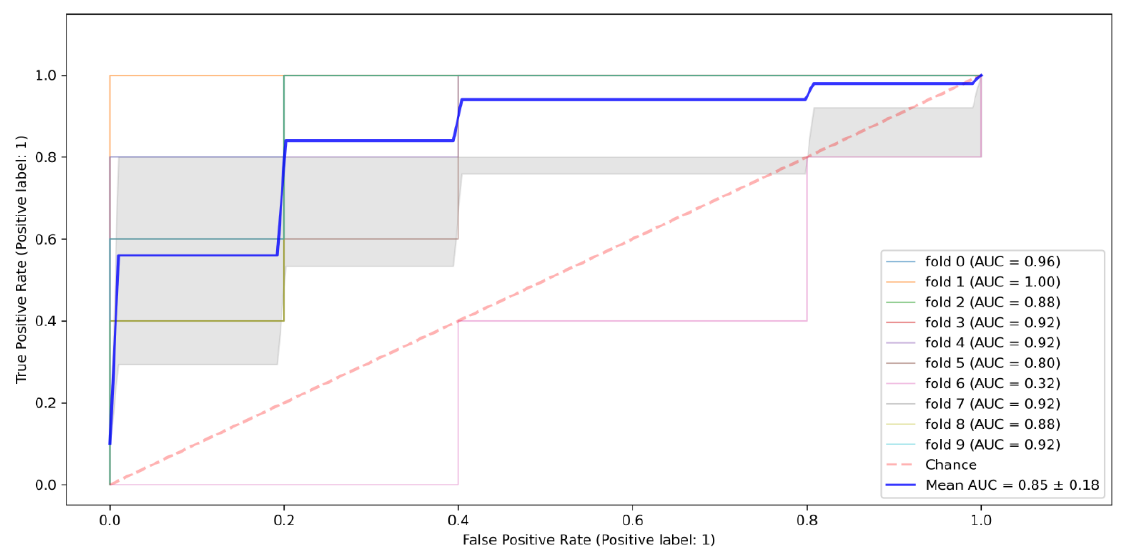
Figure 6. Bagging classifier ROC Curve.